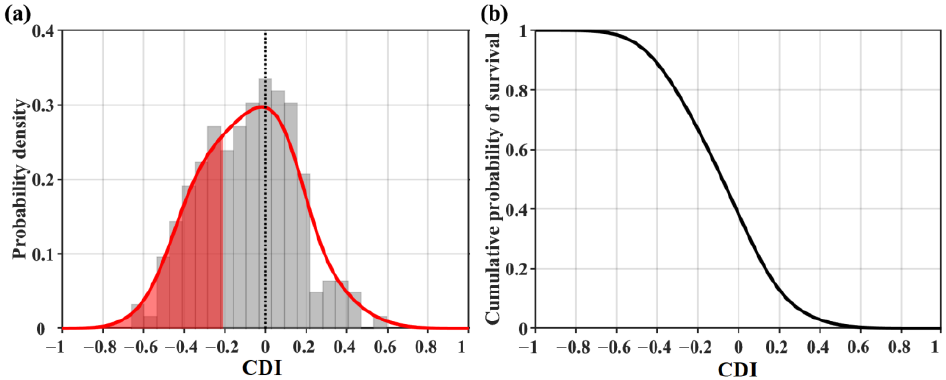
Figure 3. Probability density ( a ) and survival probability ( b ) distributions of the CDI.